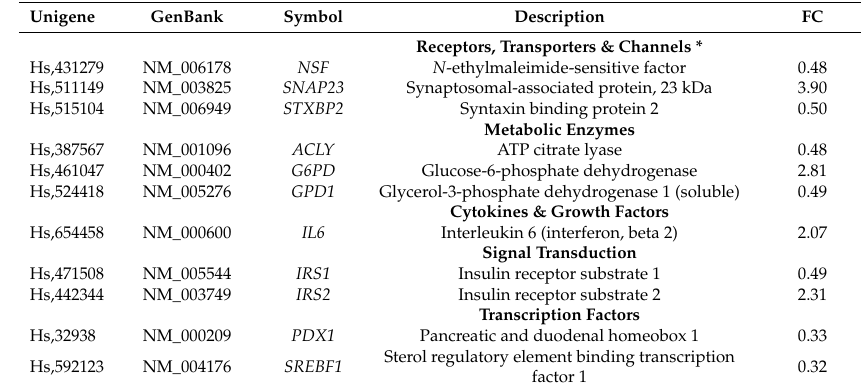
Table 4. List of 11 diabetes-related genes with at least ± 2-fold regulation in leukocytes from the GDM/ SIRT1 ( ↑ ) pregnancies ( n = 9) compared to the NGT controls ( n =